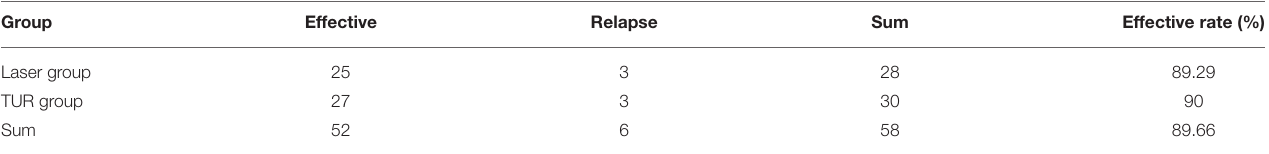
TABLE 3 | Comparison of the effectiveness.